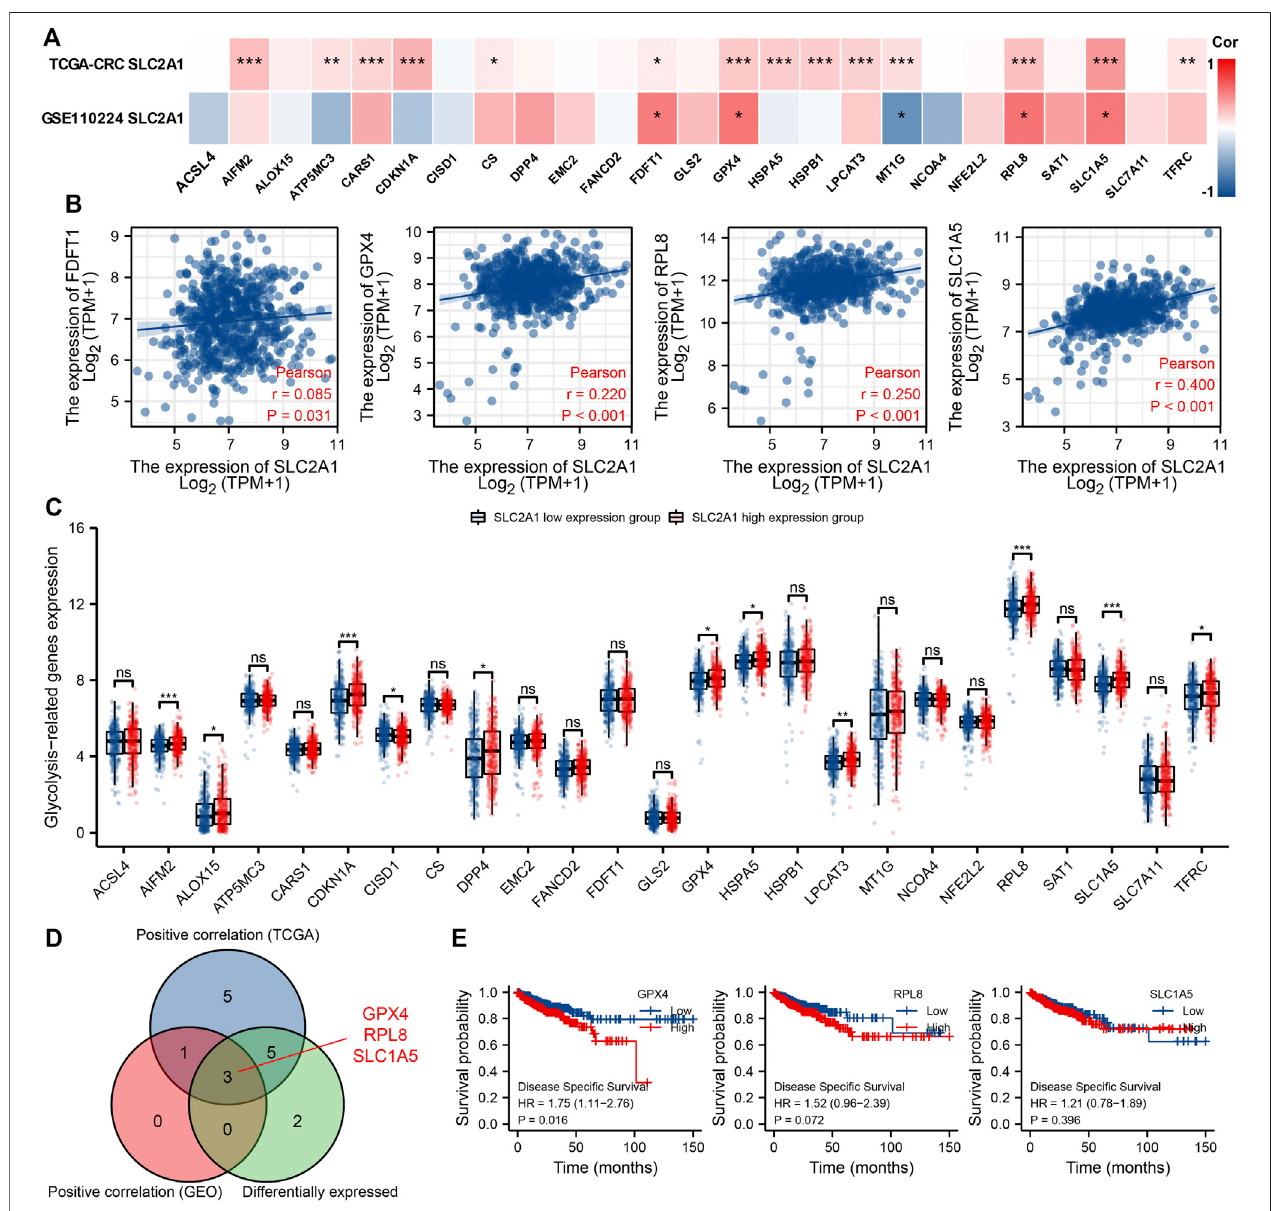
FIGURE 8 | Associations of SLC2A1 expression with ferroptosis relative genes in colorectal cancer (CRC). (A) GSE110224 and TCGA CRC cohort analyzed the association between the SLC2A1and the 25ferroptosis relative genes expression in CRC. (B) TCGA CRC cohort was analyzed and a scatter plot wasdrawn to display the correlation between SLC2A1 and the expression of ferroptosis relative genes, including FDFT1, GPX4, RPL8, and SLC1A5. (C) The differential expression of 25 ferroptosis relative genes between high and low SLC2A1 expression groups in CRC tumor samples. (D) Venn diagram indicated both expression association and differential expression of genes, including GPX4, RPL8, and SLC1A5. (E) Kaplan – Meier curve ofGPX4, RPL8, and SLC1A5. *, p < 0.05; **, p < 0.01; ***, p < 0.001; ****, p < 0.0001; ns, no signi fi cant.